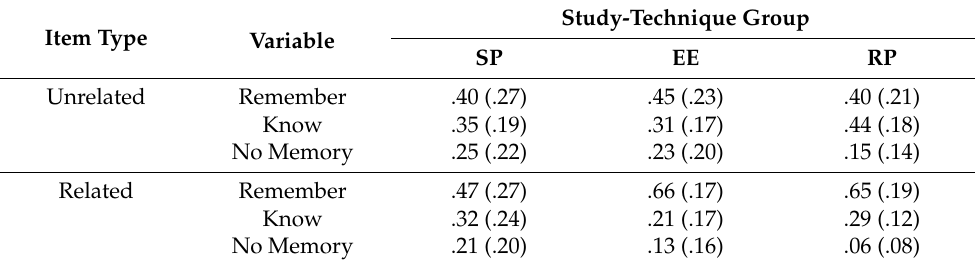
Table 1. Mean remember, know, and no memory